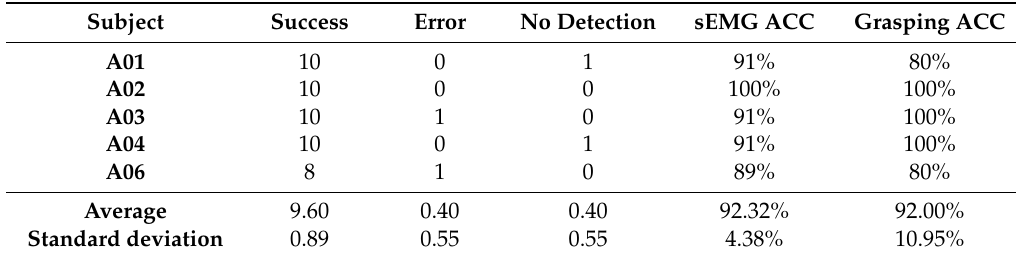
Table 3. sEMG performance and grasping accuracy for object position